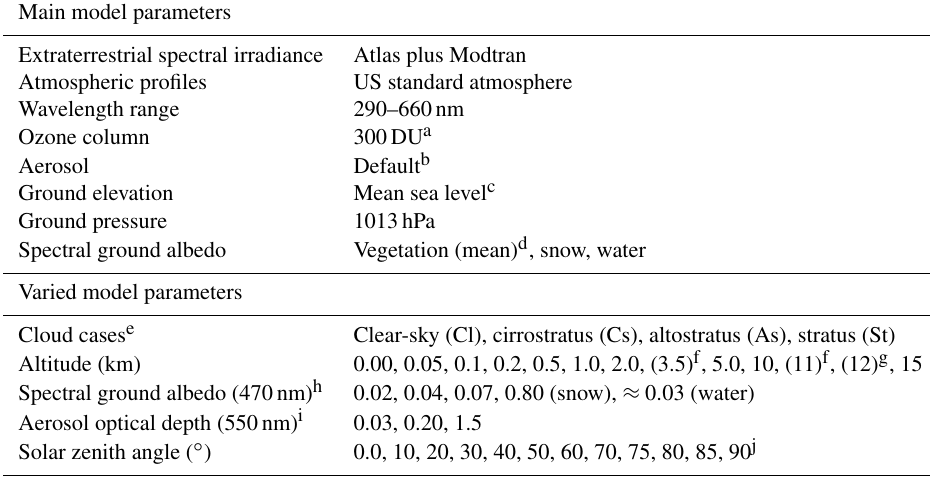
a Additional calculations with 200 and 400DU for selected altitudes of 1 and 10km. b libRadtran default aerosol properties (Shettle, 1989). c Additional clear-sky calculations for 1km ground elevation. d Mean ground albedo for vegetation (Feister and Grewe, 1995). e Cloud cases according to Table 2. f In-cloud altitude for a specific cloud case. g Cloud top altitude for a specific cloud case. h Spectral albedo scaled to produce ground albedos A i Default aerosol (AOD 470 of 0.02, 0.04 or 0.07. 550 = 0 . 23 ) scaled to produce